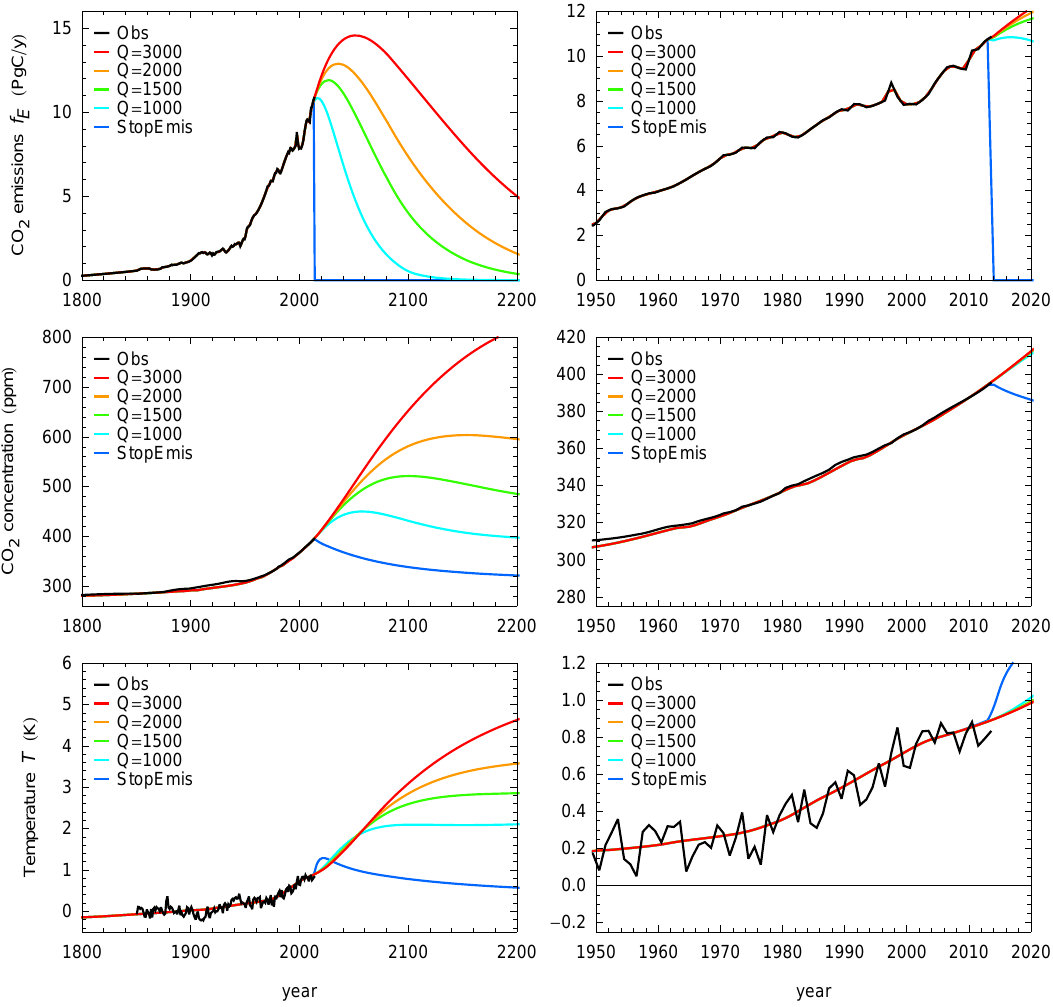
Figure 4. Total CO 2 emissions ( f E , top row) and SCCM predictions for CO 2 concentration (middle row) and temperature (bottom row), with analytic scenarios for future emissions of CO 2 and non-CO 2 gases (CH 4 , N 2 O, CFCs) such that the all-time cumulative total CO 2 emission Q takes values from 1000 to 3000PgC. Scenarios and model details (including treatment of aerosols) are given in Raupach (2013). Left panels show plots against time from 1800 to 2200; right panels zoom in to the period 1950–2020 to compare model with data. This figure is a variation with added detail of Fig. 6 in Raupach